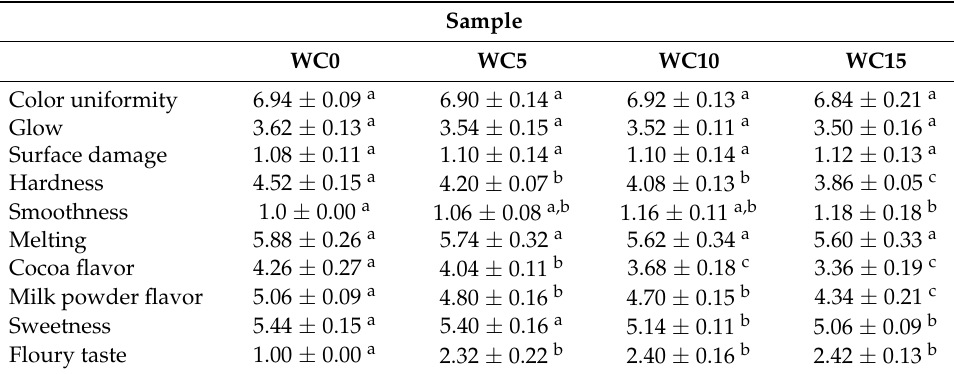
Table 6. Sensory characteristics of chocolate